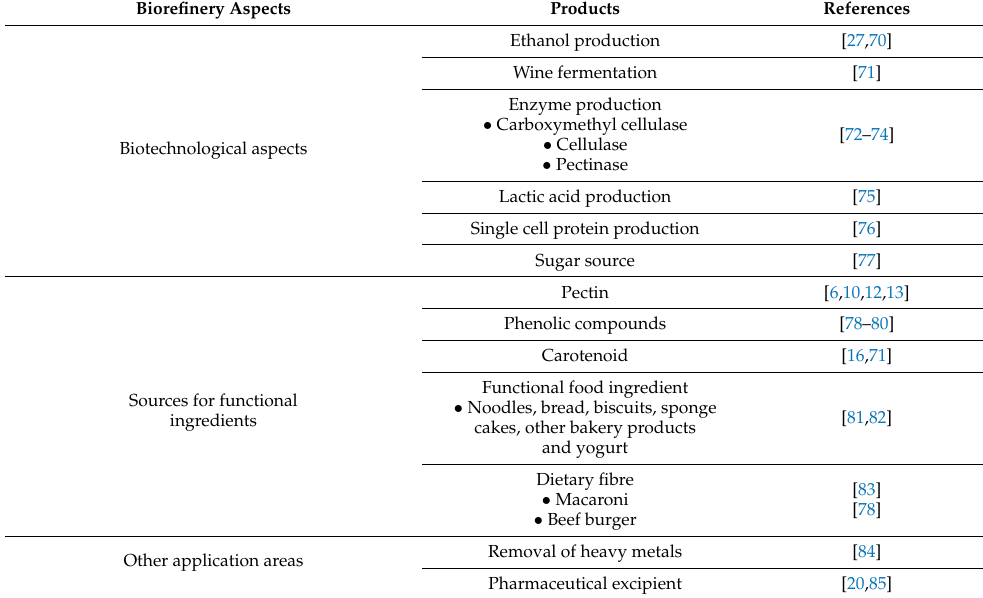
Table 3. Current research studies on mango peel biorefinery of various value-add